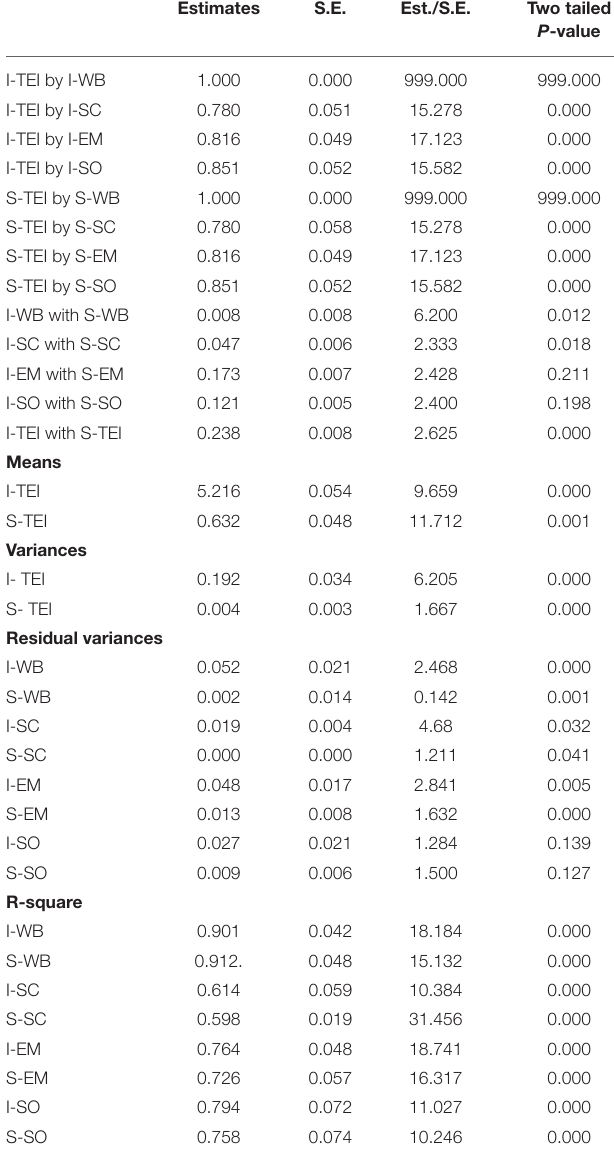
TABLE 5 | Parameter estimates for FCM.